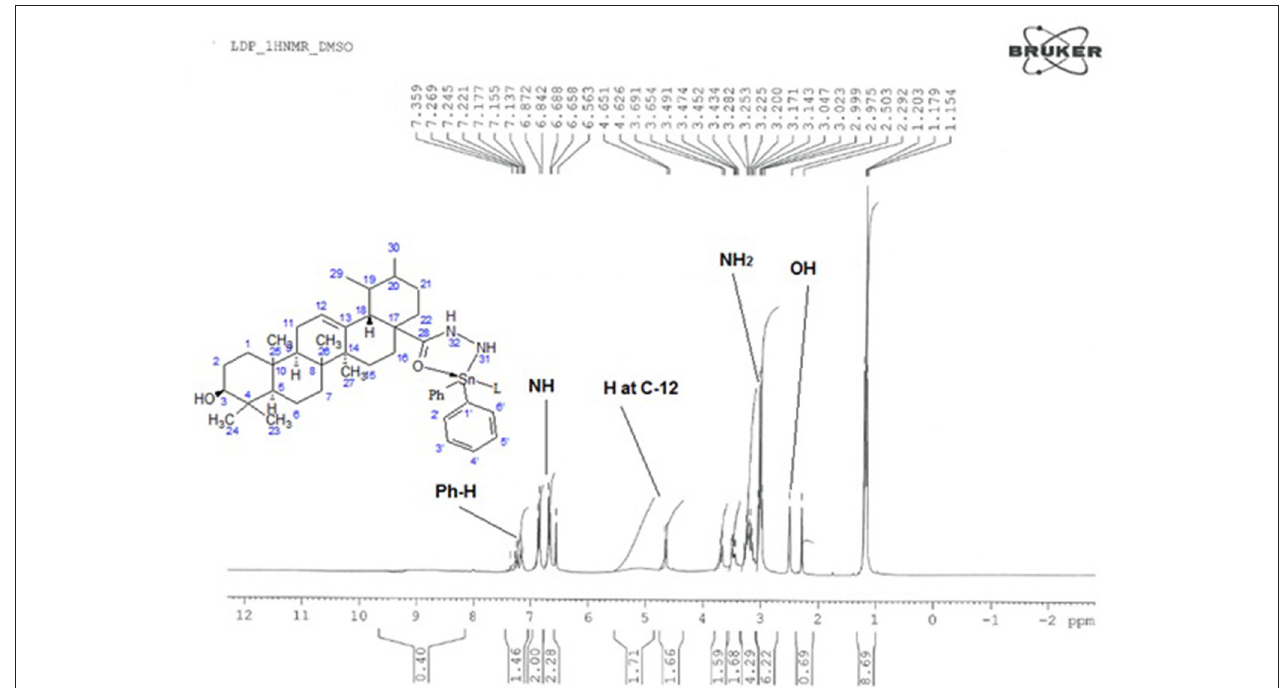
FIGURE 5 | 1 H NMR Spectrum of Diphenyltin